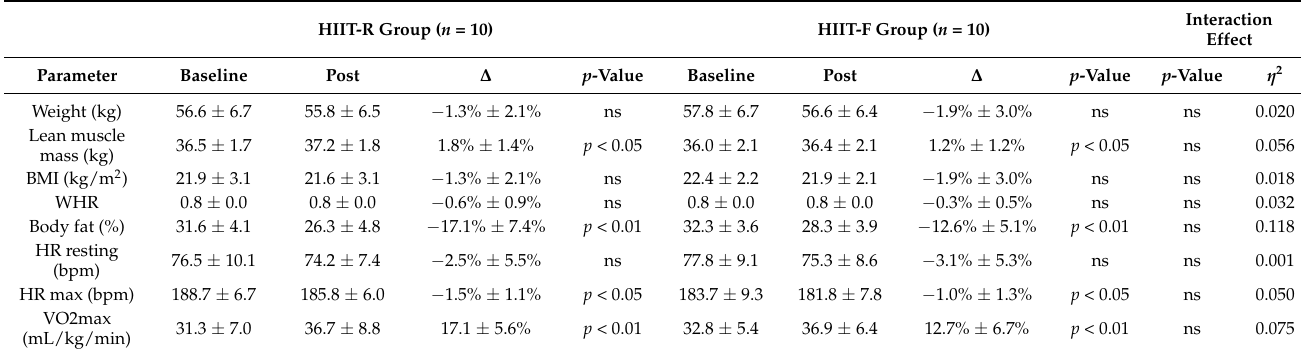
Table 3. Body composition and aerobic capacity data from HIIT-R and HIIT-F groups.